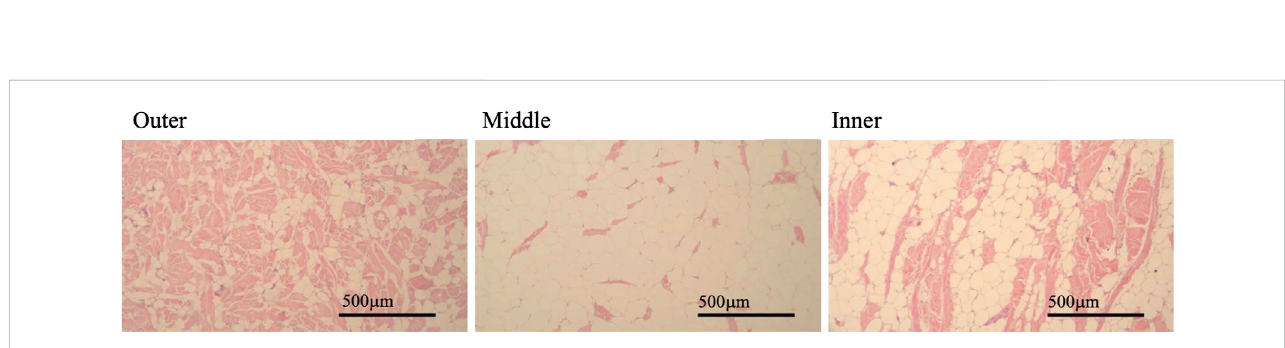
FIGURE 2 Example images of blubber from three visually identi fi ed layers in a single slide made from a full depth blubber sample. Blubber layer indicated by label above each image in panel. Pink stained areas of blubber indicates connective tissue stained, white unstained areas indicates adipocyte vacuolar space. Images taken by Jana Phipps using Jentopix Gryphax Arktur digital camera mounted on an Olympus BX-41 microscope at × 100 magni fi